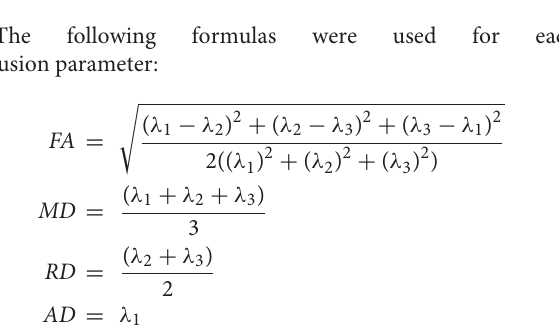
FIGURE 2 | Tractography using diffusion magnetic resonance imaging. (A) Axial and sagittal views (top to bottom) of the regions of interest (ROIs). A 4-mm-radius spherical ROI just posterior to the globe was centered on the emerging optic nerve in each eye. (B) Another 4-mm-radius spherical ROI was within the orbital apex, and its center was placed in the center of the annulus of Zinn. (C) Cleaned tractography-generated optic nerve pathways. Visualization of the ROIs and tractography was generated with the MATLAB Brain Anatomy software package